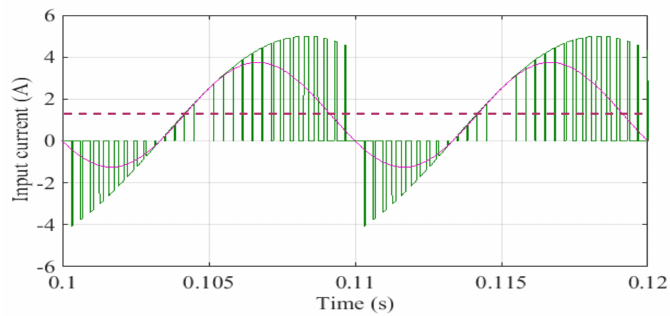
Figure 3. Ideal PWM inverter input current (green trace), its averaged counterpart (purple trace), and average component (dashed line) in case of m = 1, I o = 5 A (sinusoidal output current, 50 Hz), and ϕ = 60 ◦